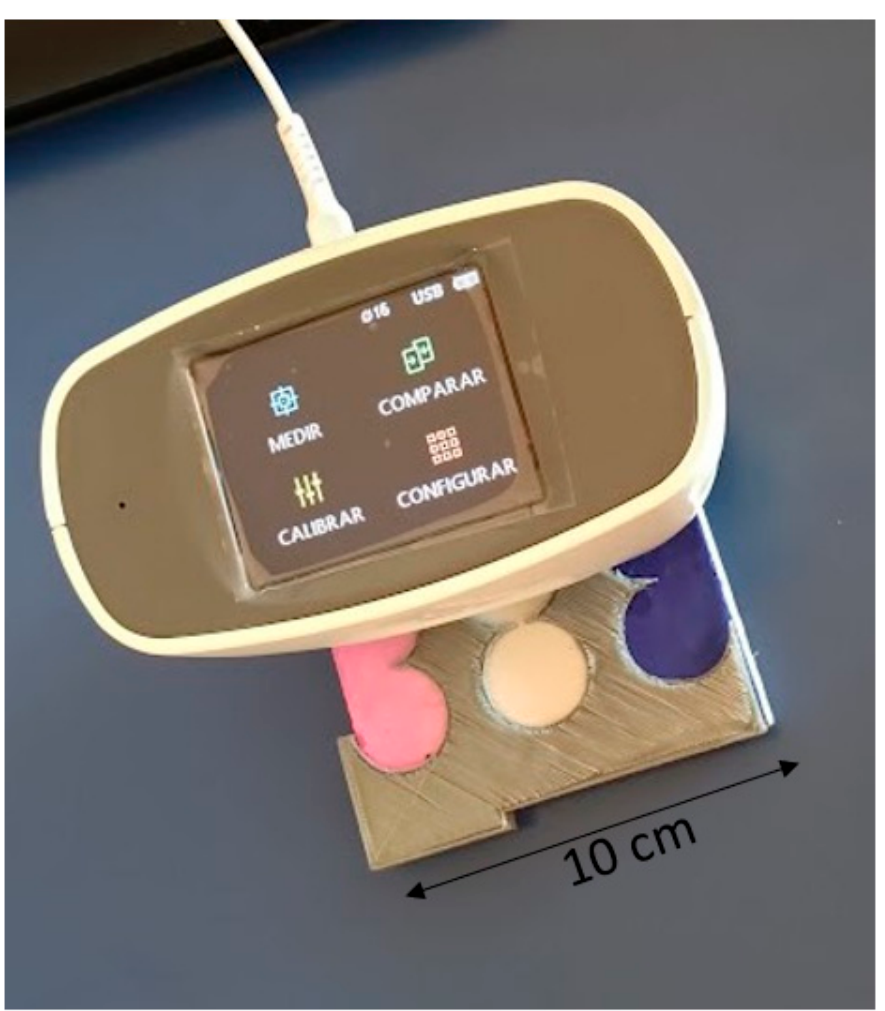
Figure 6. Color measurement with spectrophotometer using template for standardization.